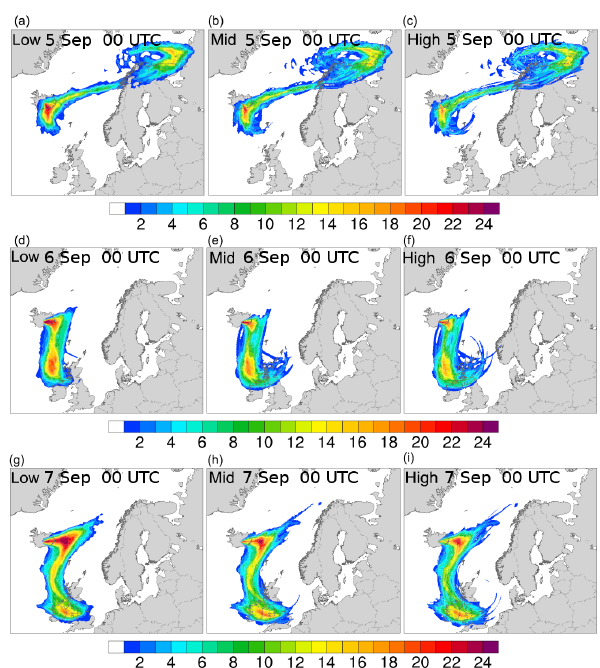
Figure 2. Map of the number of ensemble members that locally ex- ceeds a 5DU SO 2 limit. Counted after 48h in the low, mid, and high resolution ensembles, in the left, middle, and right columns respec- tively for start time 00:00UTC on 3 September (a, b, c) , 00:00UTC on 4 September (d, e, f) , and 00:00UTC on 5 September (g, h, i) .